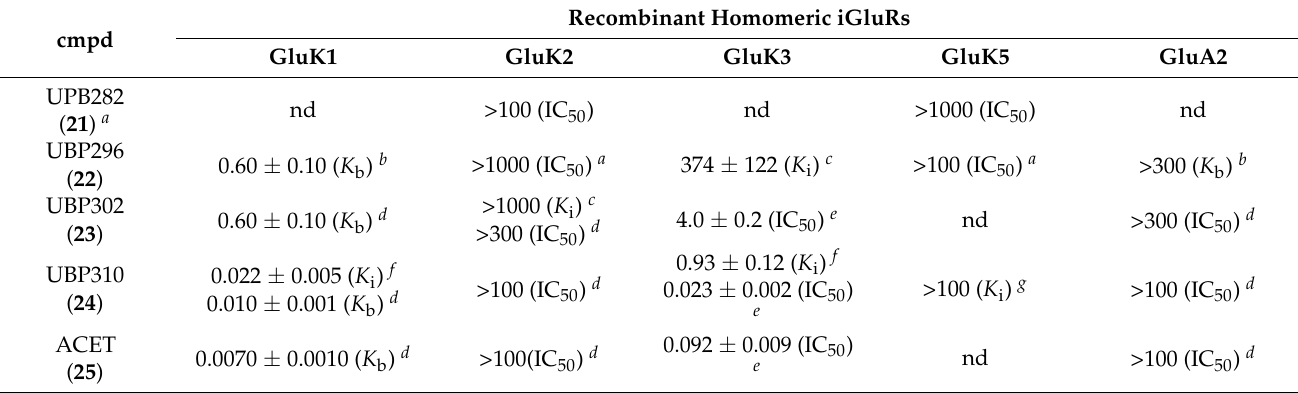
Table 4. Activity of willardiine-derived antagonists at recombinant homomeric AMPA and kainate receptors (all values in µ